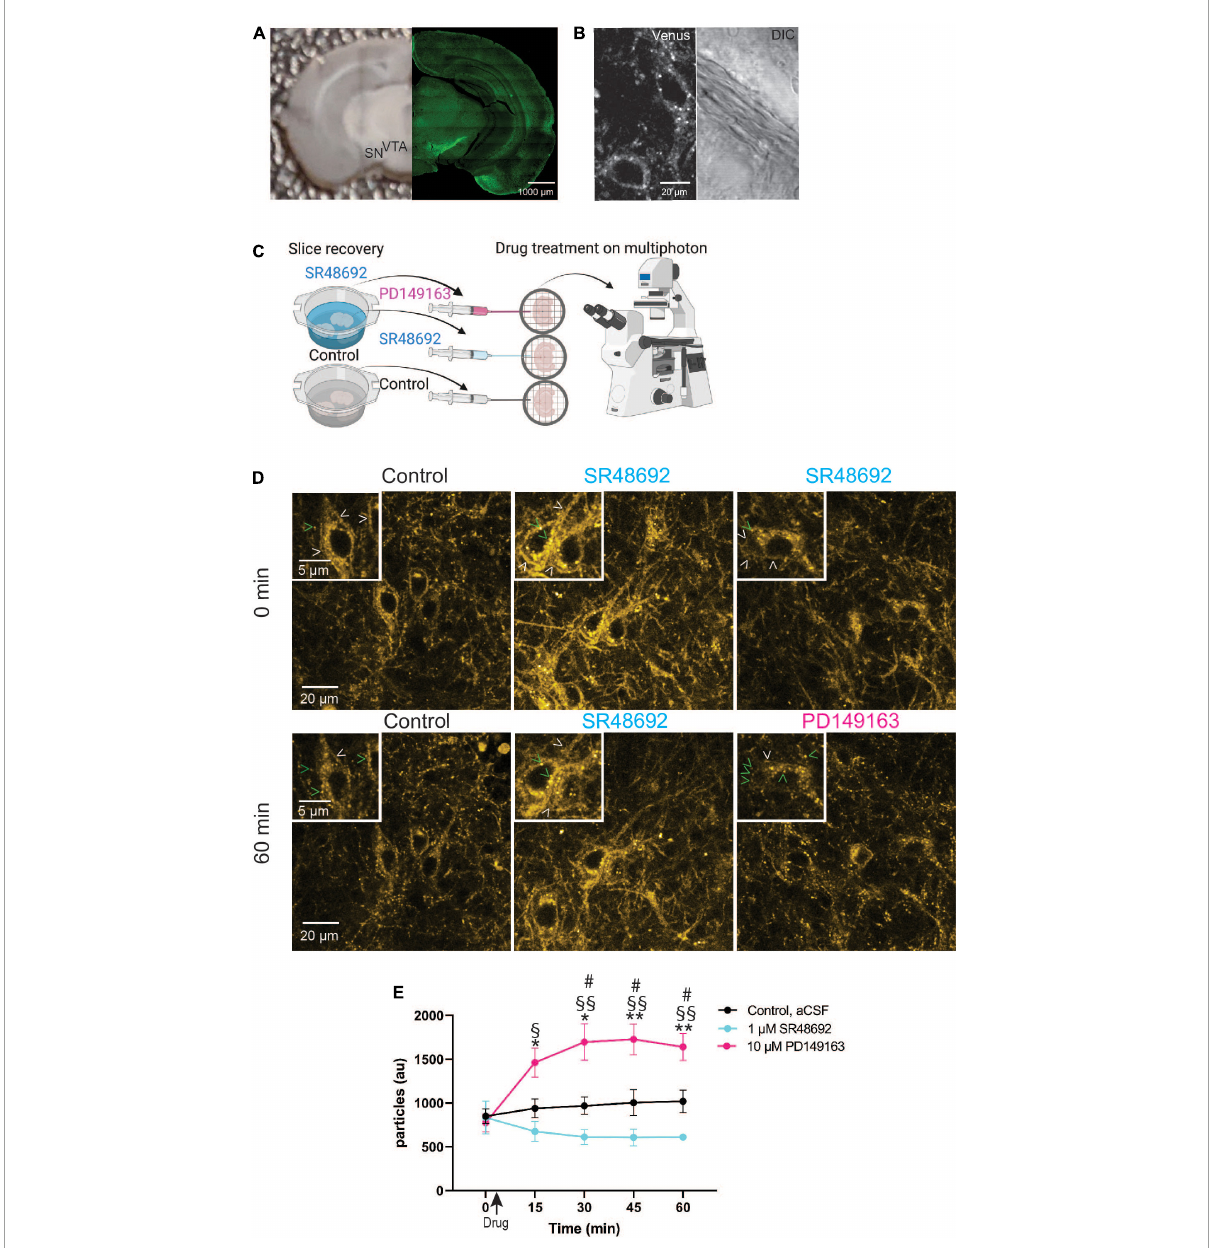
FIGURE5 Monitoring GPCR activation in dopaminergic midbrain neurons in acute slices using NTSR1-Venus animals. (A) Shown is a representative image of an acute slice prepared from Ntsr1 Venus / Venus animals used for multiphoton imaging (left) and an image of NTSR1-Venus intrinsic expression (right). Scale bars are 1000 µ m. (B) A representative high magnification two-photon image shows healthy living NTSR1-Venus cell bodies in acute slices prepared from control Ntsr1 Venus / Venus animals. Venus expression is shown (left) and DIC is shown (right). Scale bars are 20 µ m. (C) Experimental schematic shows during slice recovery, 1/3 of slices were incubated in control cutting solution, 2/3 of slices were incubated in 1 µ M SR48692, and following 0 min image acquisition, either aCSF (black), 1 µ M SR48692 (blue), or 10 µ M PD149163 (pink) was added to the aCSF flowing in the perfusion system. Scheme created with www.biorender.com. (D) Representative multiphoton images of acute slices containing the VTA from Ntsr1 Venus / Venus animals used to measure NTSR1-Venus internalization. Slices were first incubated with either cutting solution or 1 µ M SR48692. Baseline images were obtained and following image acquisition the indicated drug was added—control (aCSF), 1 µ M SR48692 or 10 µ M PD149163. Scale bars are 20 µ m and 2 µ m (insets). Arrowheads indicate representative puncta (green) or membrane (white) localized receptor. (E) Internalization of NTSR1-Venus was quantified as average number of particles per image. Images are representative of n = 4–5 acute slices per condition from Ntsr1 Venus / Venus animals. Graph depicts the mean ± SEM. *Indicates significance compared to PD149163 at 0 min, # comparison between PD149163 and control, §comparison between PD149163 and SR48692. * # , § p < 0.05, ** §§ p < 0.01 via 2way ANOVA [significant time effect F ( 2 . 406 , 24 . 06 ) = 7.457; p = 0.0019], significant drug effect F ( 2 , 10 ) = 11.13; p = 0.0029 with a significant interaction F ( 8 , 40 ) = 11.41; p <